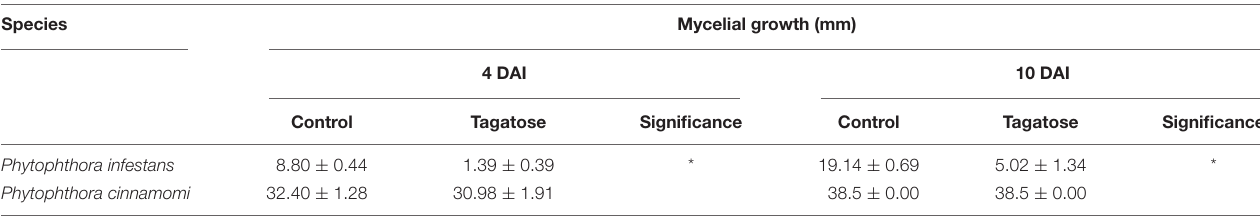
TABLE 1 | Effect of tagatose on Phytophthora spp.